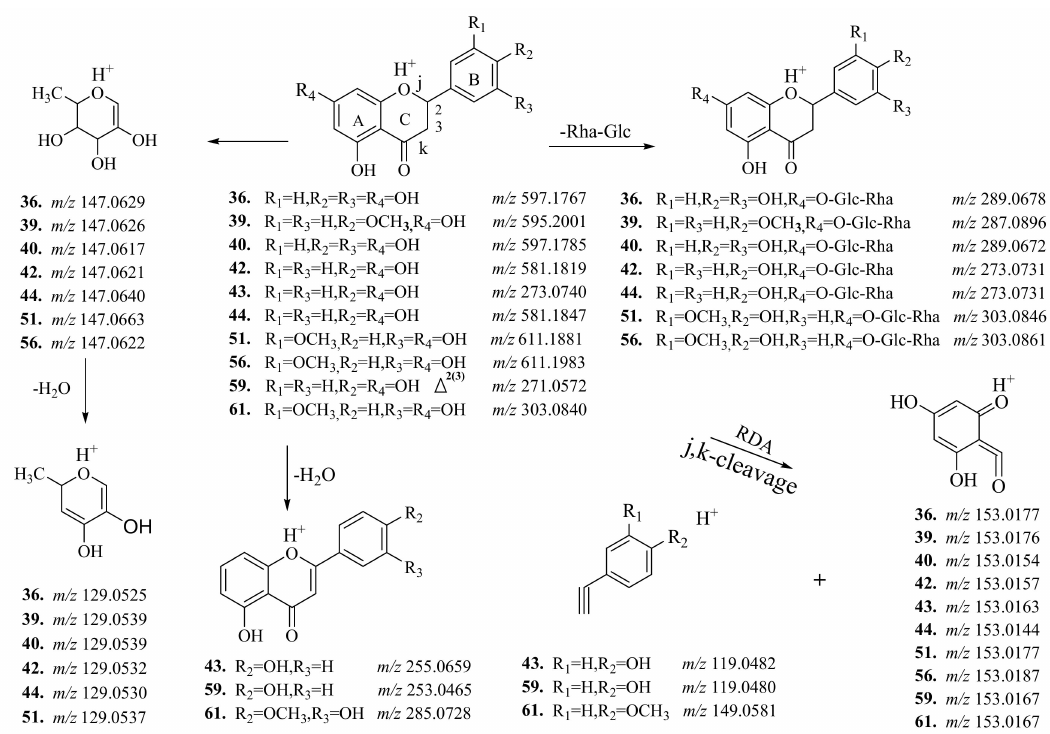
Figure 2. The proposed fragmentation pathways of 10 flavonol and flavonol glycoside